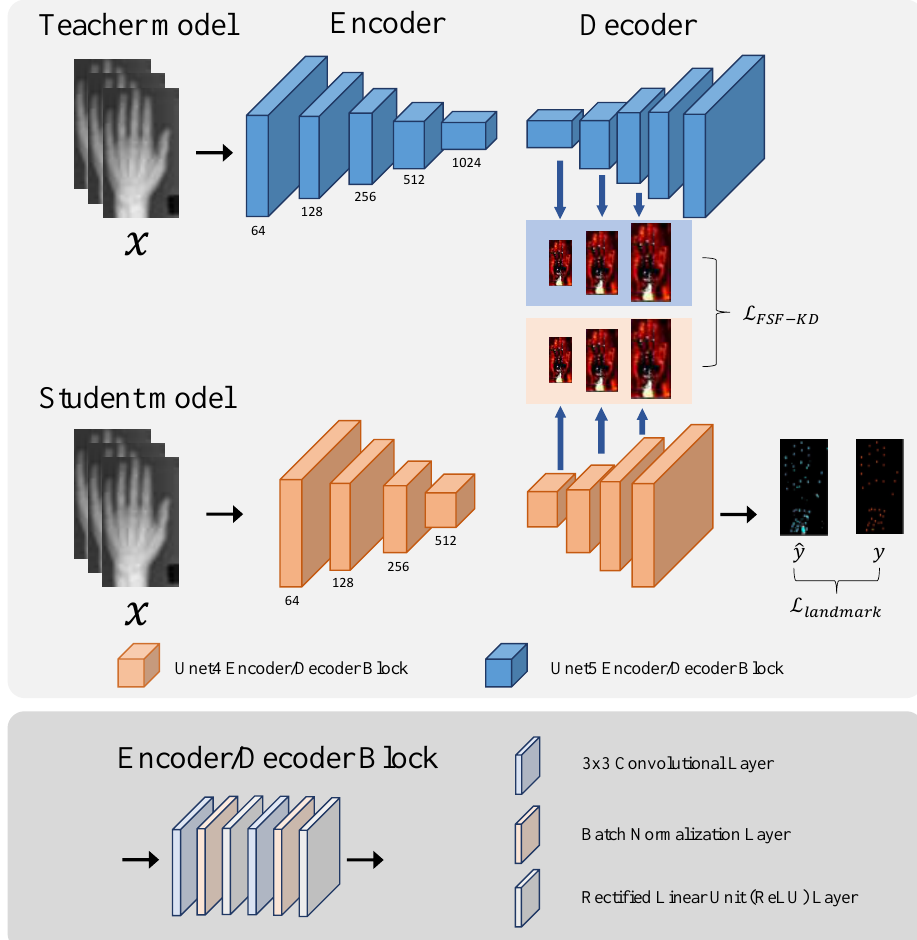
Figure 4. An overview of the feature-sharing fast landmark detection (FSF-LD) model-training strategy: Apart from the ground truth, the pretrained teacher model provides a student model with extra supervision guidance via L FSF − KD . The loss L FSF − KD imposes the student model to imitate the teachers’ representations from intermediate